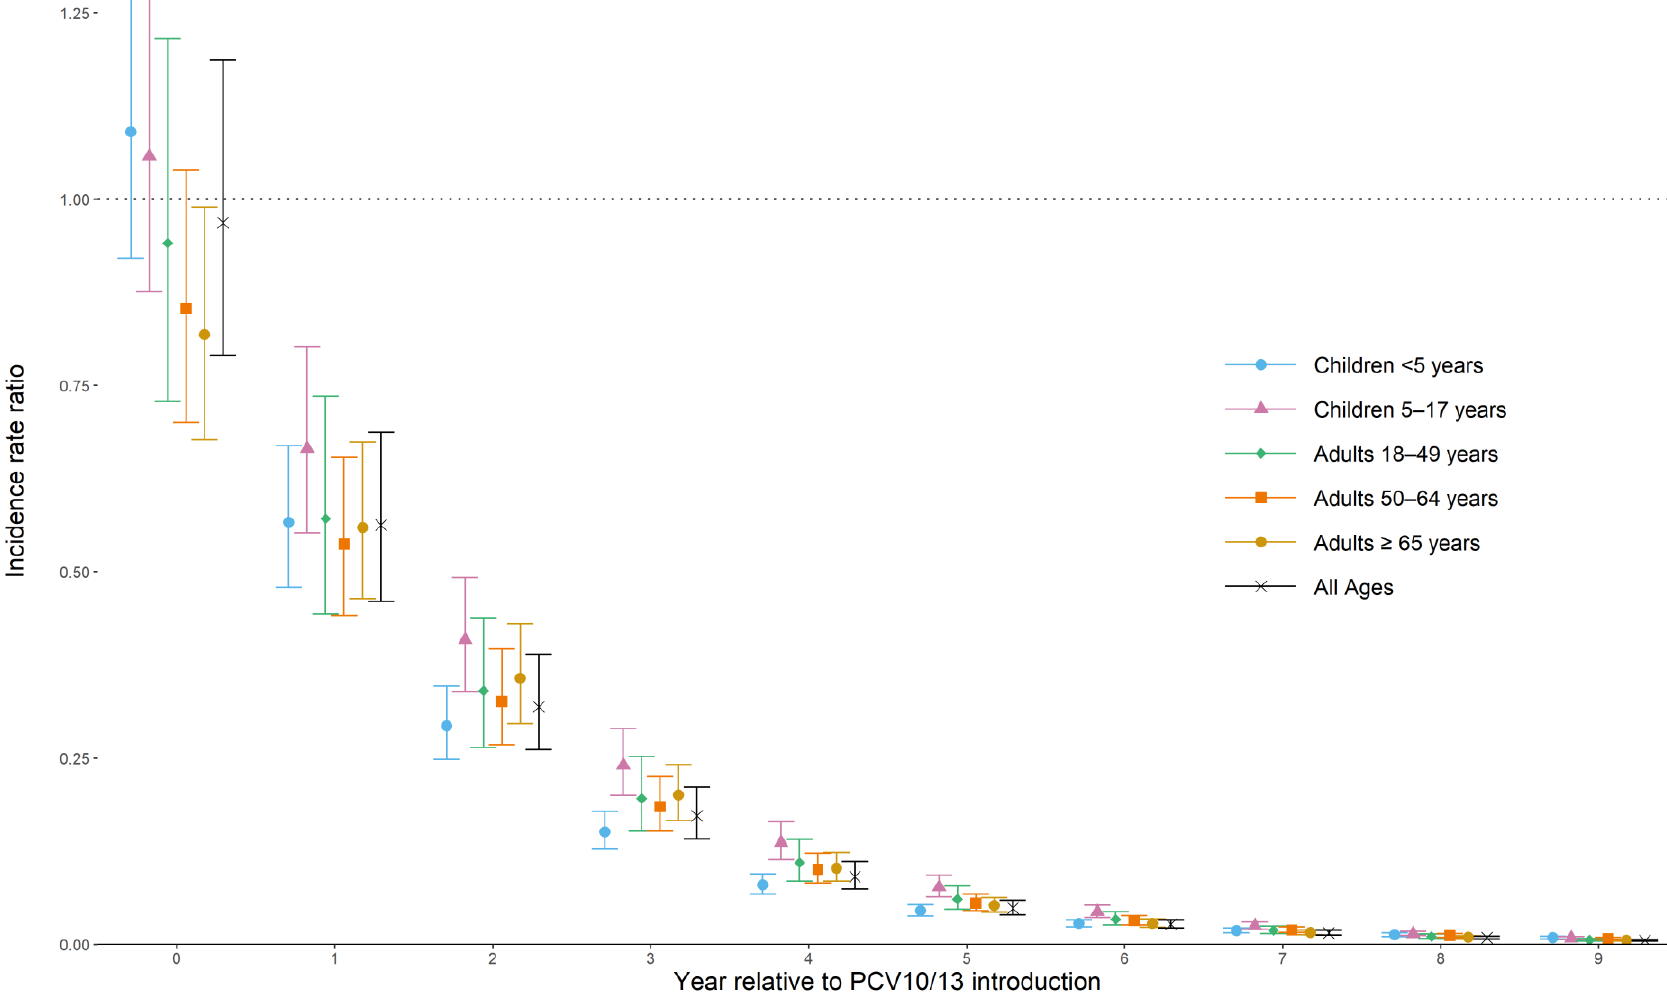
Figure 2. All-site weighted average incidence rate ratios for serotype 1 invasive pneumococcal disease for all ages and by age group. All ages’ analysis (in black) is not an average of each age-specific estimate in each year but rather a re-analysis of the total cases from all ages reporting at each site.